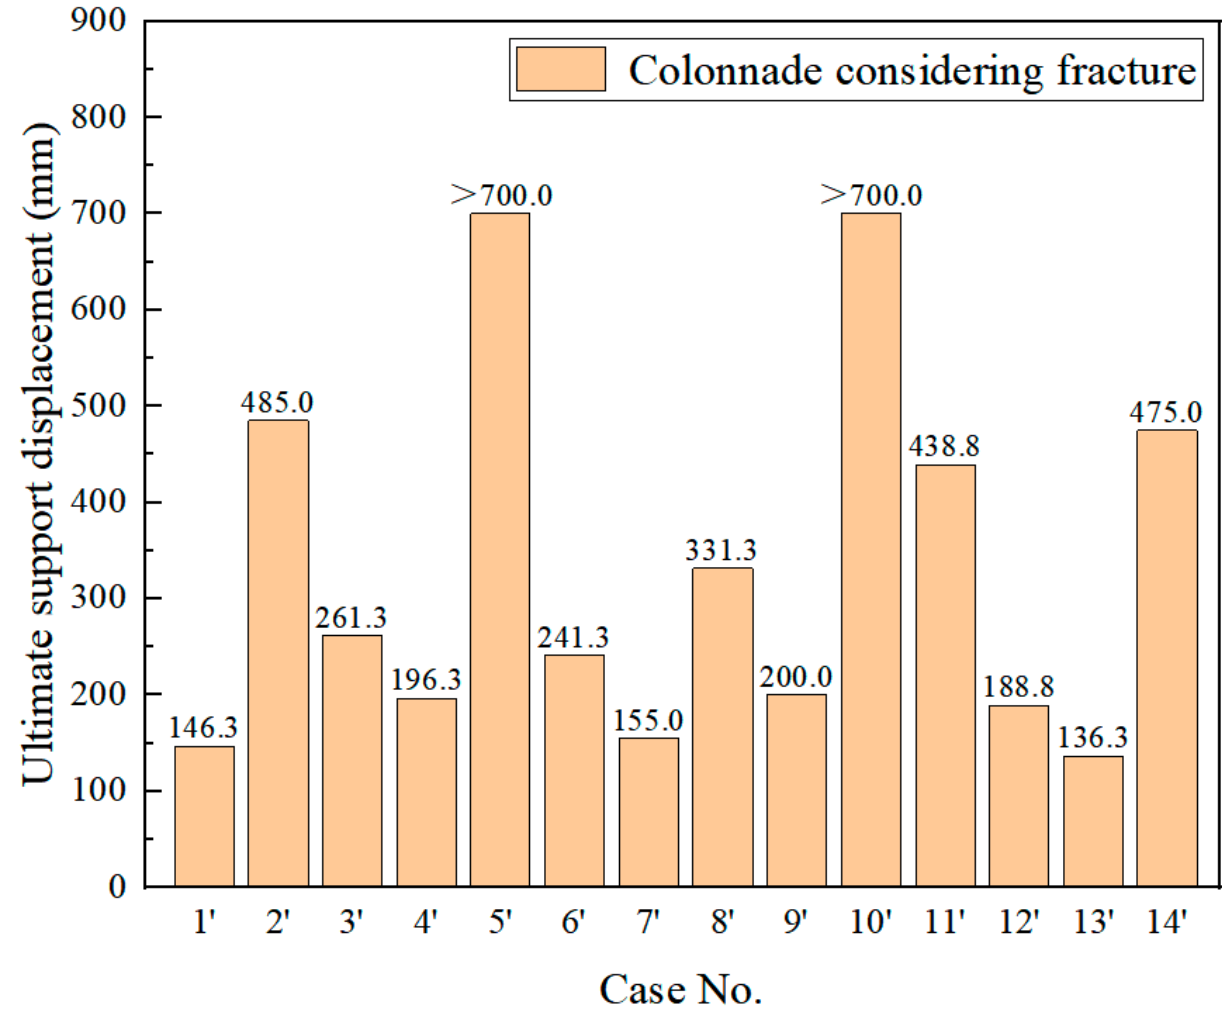
Figure 14. Ultimate support displacement of the colonnade considering fracture.